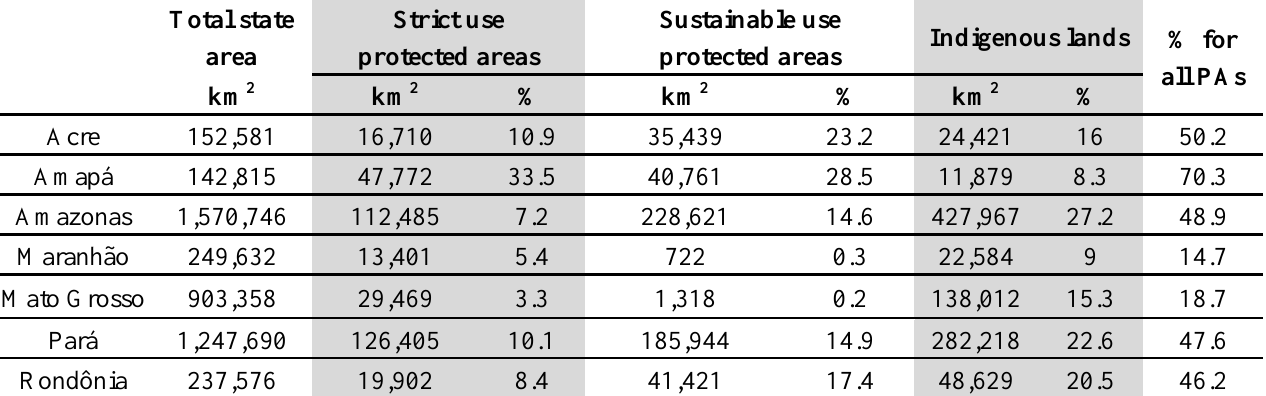
Table 2. Area and percentage of protected areas in Amazonian states.